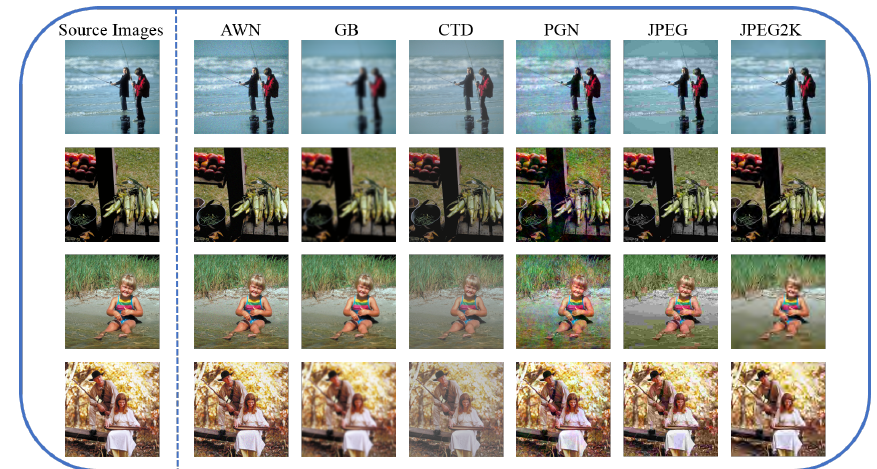
Figure 4. Some samples from the CSIQ database.